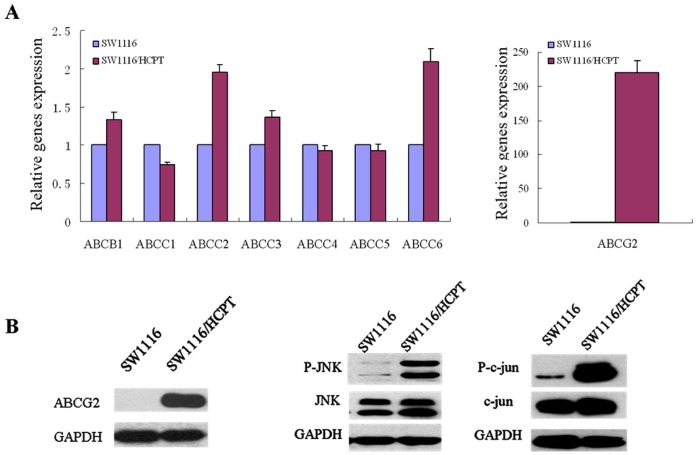
The expression of ABC transporters and activation of JNK/c-jun in parental and multidrug resistant cells. A.The mRNA expression of ABCB1, ABCC1–6, ABCG2 in SW1116 and SW1116/HCPT cells were measured by Real-time PCR. B. SW1116 and SW1116/HCPT cells were harvested to prepare cell lysates. The lysates were subjected to SDS–PAGE and blotted with antibodies. Levels of ABCG2, phosphorylated JNK (P-JNK), total JNK, phosphorylated c-jun (P-c-jun) and total c-jun were detected.